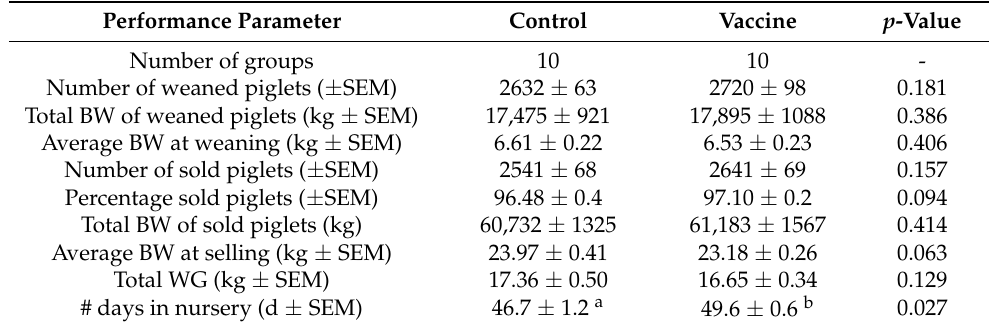
Table 2. Performance data of a comparative field trial with a historical control group with standard antimicrobial treatment and a vaccine-treated group using Coliprotec F4F18 (Elanco) on a farm with clinical problems of post-weaning diarrhea due to F4-ETEC. Significant differences are indicated by the superscript letter and their p